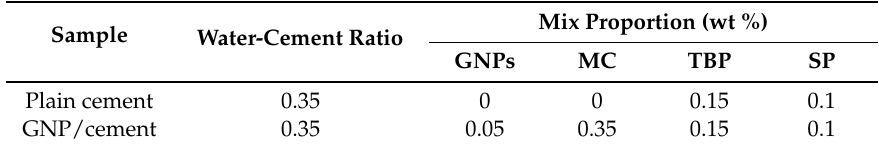
Table 6. Proportion of the